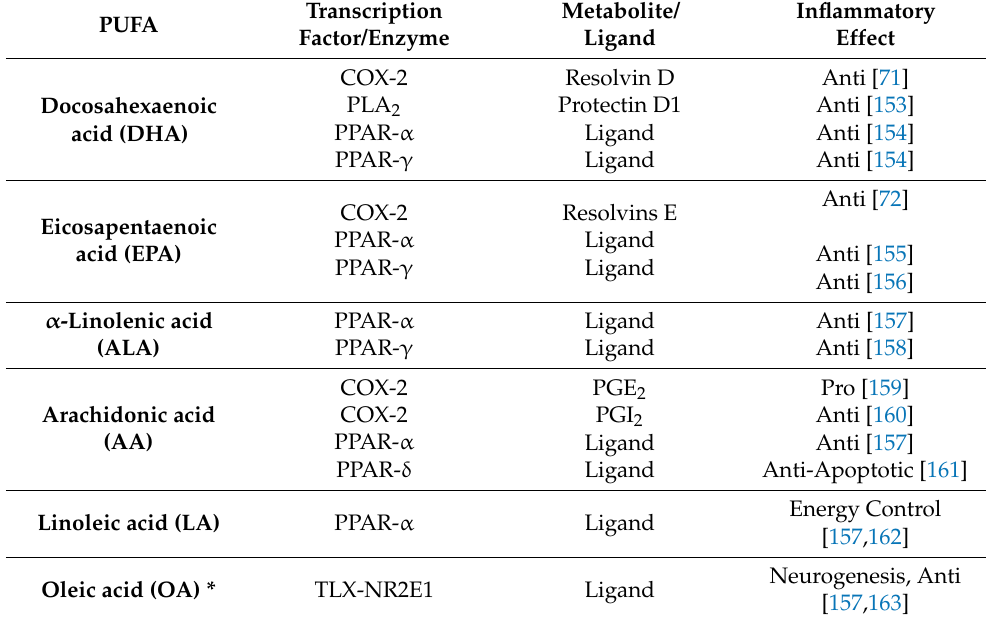
Table 2. PUFAs and their relevant metabolic enzymes/ligand